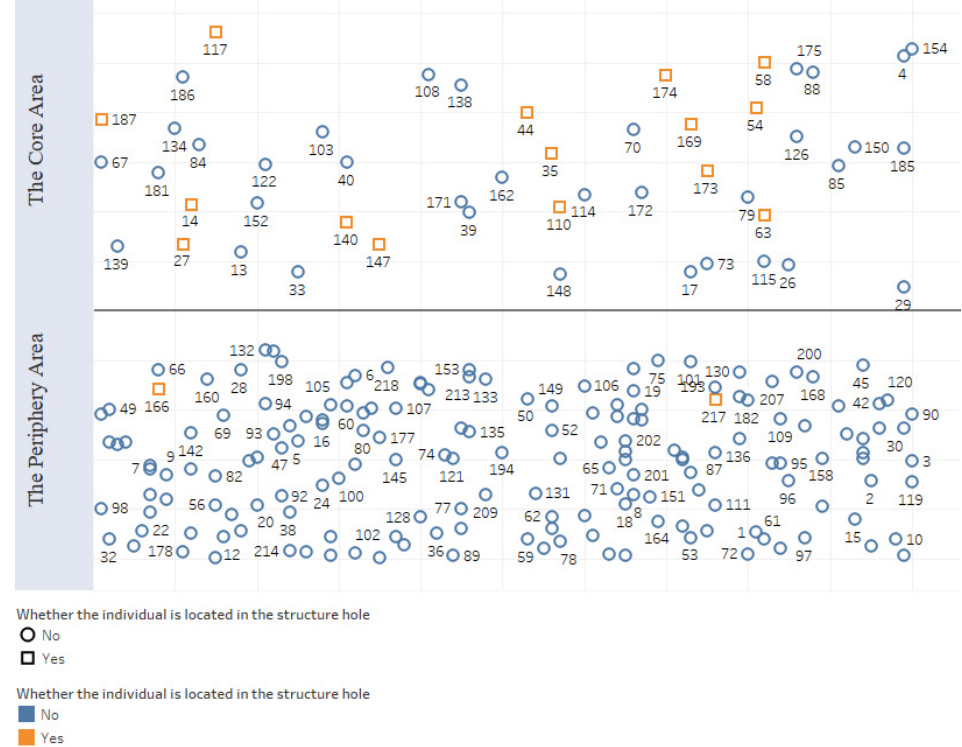
Figure 5. Distribution of opinion leaders’ core–periphery positions.